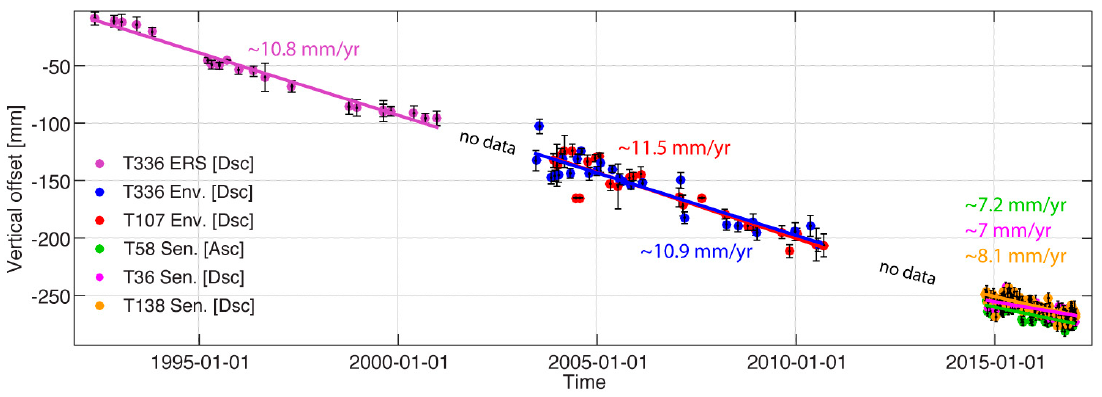
Figure 8. Time series of the vertical displacement at the selected PS points circled in center of Figure 6 (referenced to points in area labeled R in Figure 6).